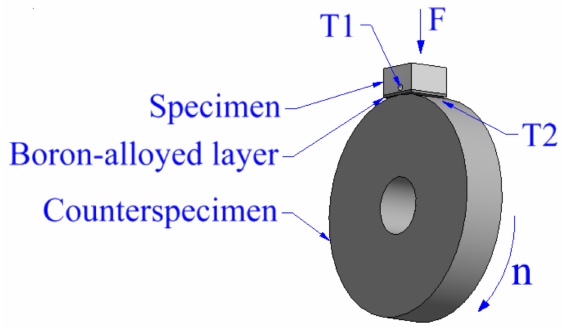
Figure 2. Scheme of the wear test.